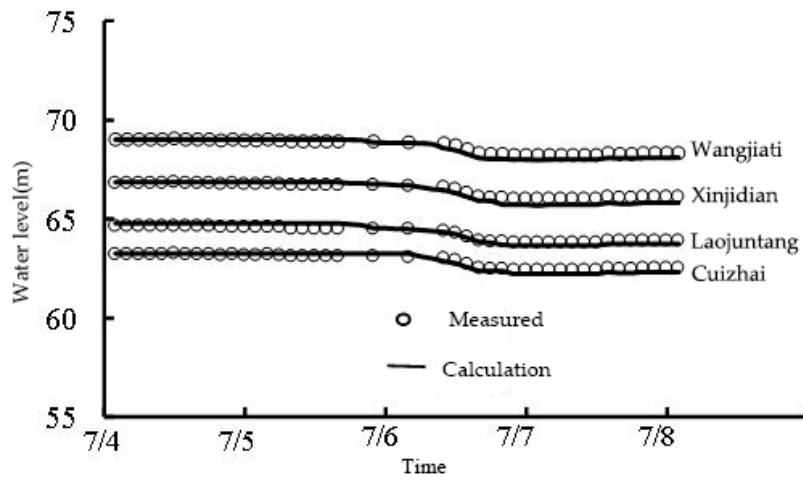
Figure 3. Comparison of measured and calculated water levels.